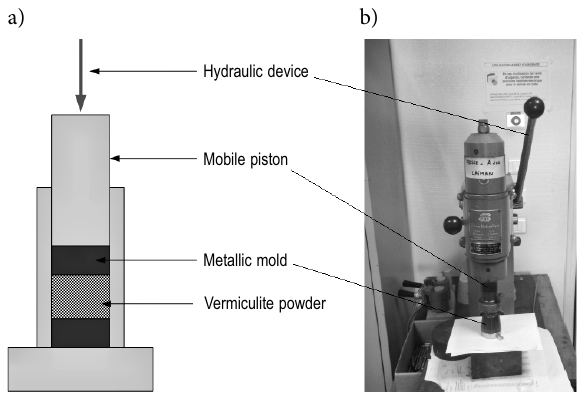
Fig. 1. Preparation process of the CEV samples: (a) schematic of the implementation tool (b) picture of the implementation tool